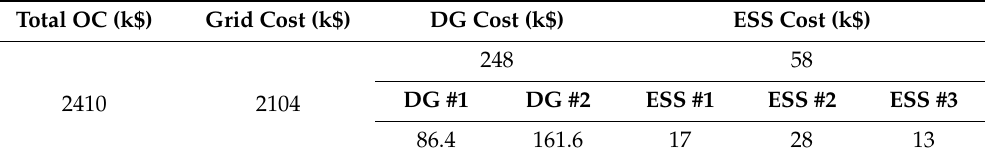
Table 4. Operation cost for the test network in Case